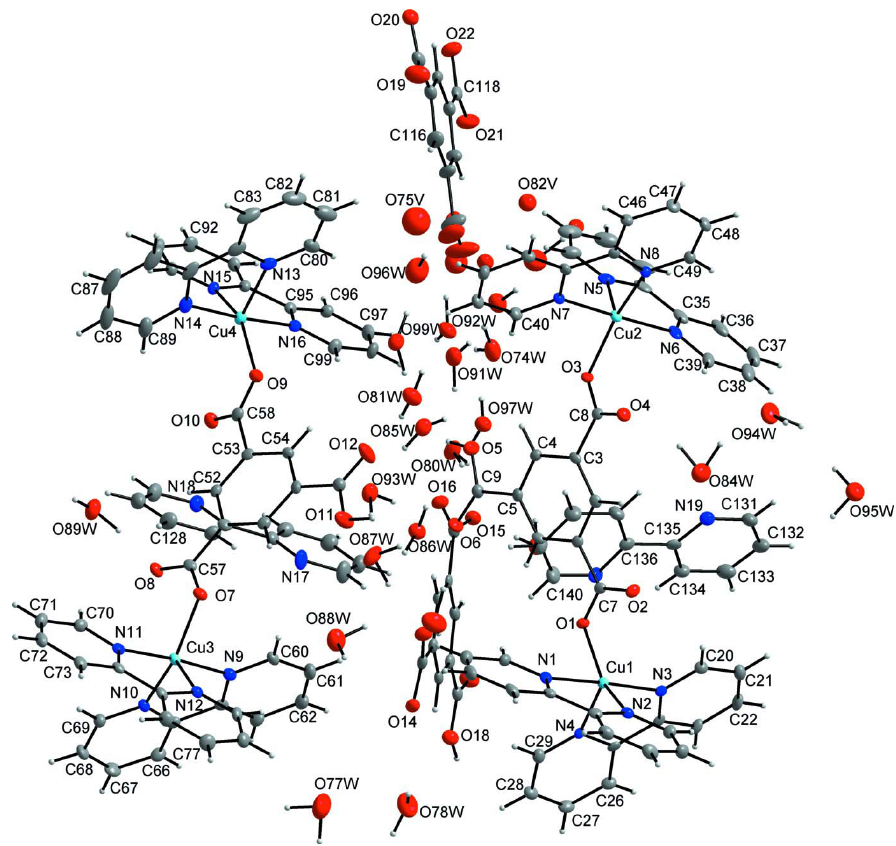
Figure 1 The molecular structure of the title complex. The non-H atoms are drawn as 40% probability displacement ellipsoids. Some of atom labels are omitted for